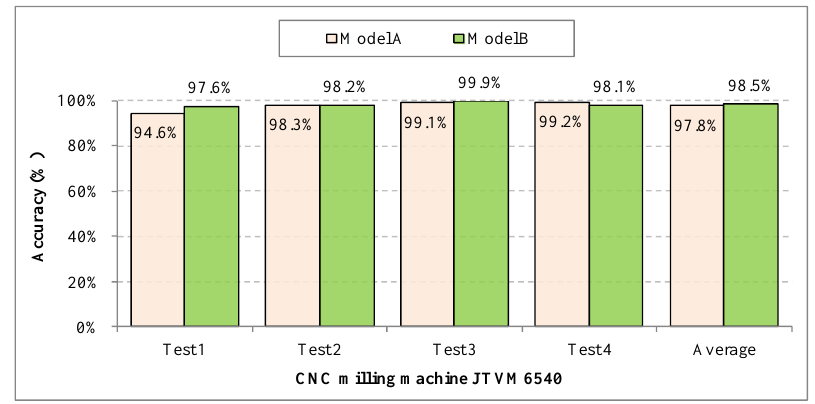
Figure 9. Comparison of accuracy of model A and B for JTVM6540 CNC milling machine.